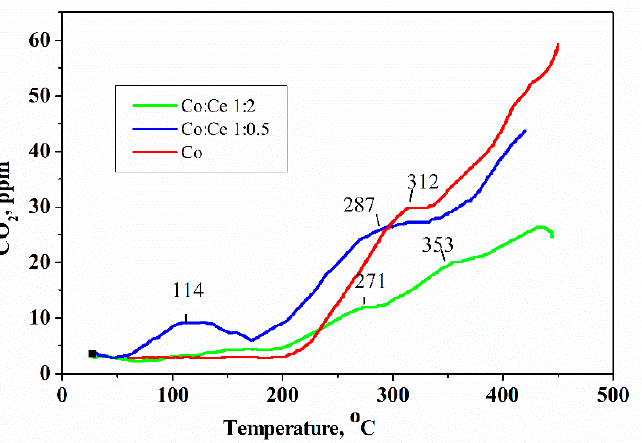
Figure 8. C 3 H 8 /TPR experiments of monocomponent Co and bi-component CoCe catalysts.